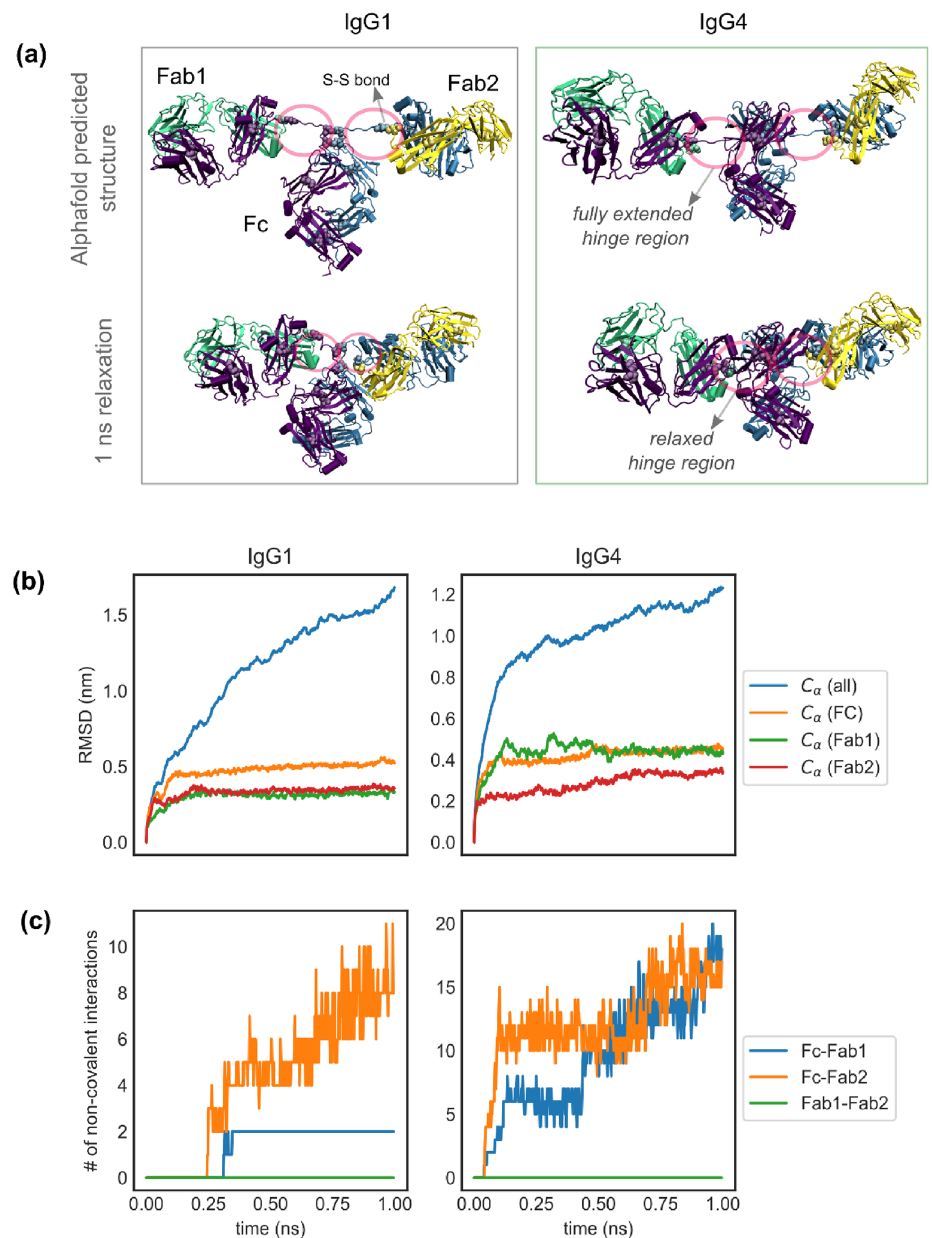
Figure 1. ( a ) Snapshots showing AlphaFold predicted structures of IgG1 and IgG4 antibodies and the corresponding conformations after 1 ns of molecular dynamics relaxation. The positions of cysteine residues forming disulfide bonds are displayed as Van der Waals beads and the spatial location of the hinge regions are marked by circles. ( b ) Time series of the root mean squared deviation (RMSD) in the alpha carbon ( C α ) positions for the whole antibody (all), Fc, Fab1 and Fab2 domains. The individual domains undergo a minor rearrangement and stabilize with 0.1 ns, while the rmsd for the whole antibody shows a growing trend even past 1 ns. ( c ) Time series showing the number of non-covalent interactions between the Fc, Fab1 and Fab2 domains. Fc–Fab2 interactions are dominant in IgG1 while the Fc interacts with both Fabs in IgG4. Fab1–Fab2 interactions are non-existent in both